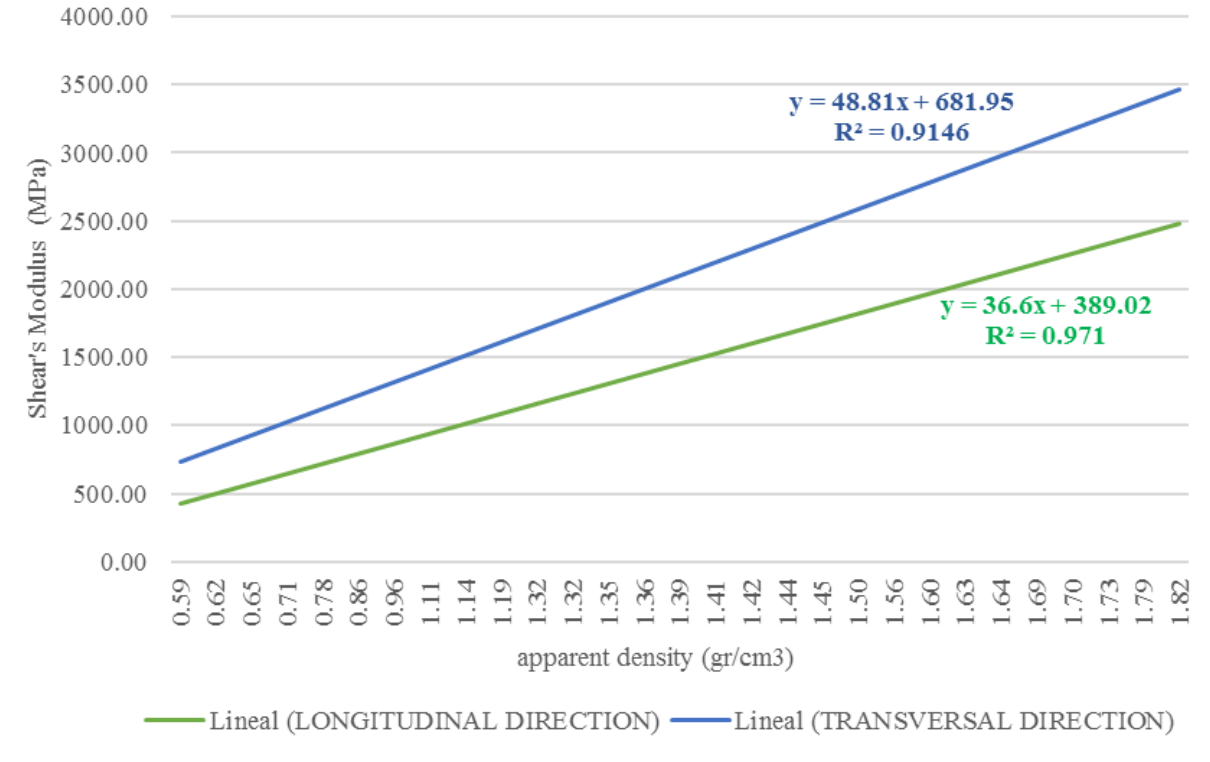
Figure 8. Relationship between apparent density and Shear’s modulus for cortical tissue affected with OI in the longitudinal and transversal direction.